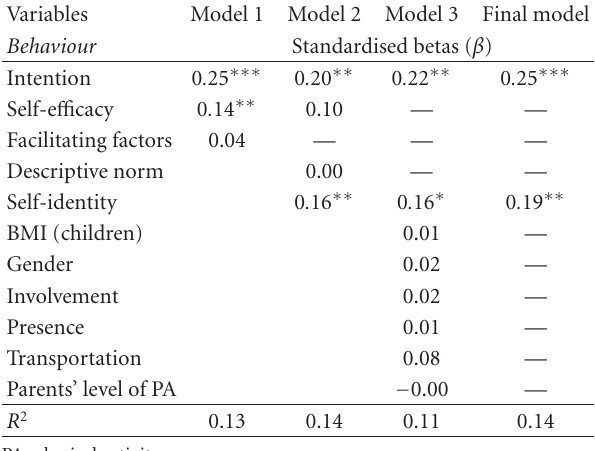
Table 1: Hierarchical regression analyses for the prediction of behaviour.